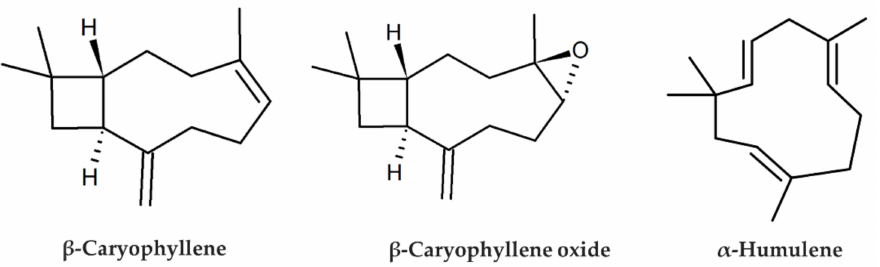
Figure 2. Chemical structures of plant-based caryophyllane sesquiterpenes with immunomodulatory